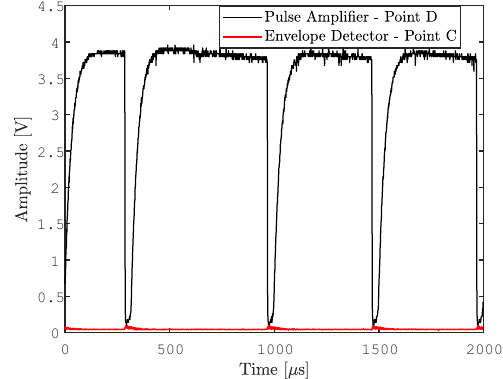
FIGURE 7. Measured signals at points C and D, from Fig 2.